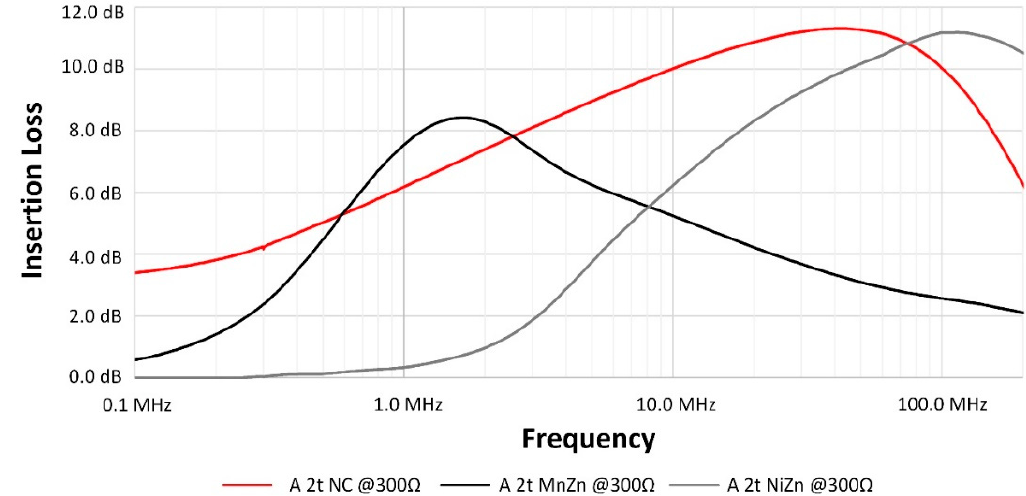
Figure 14. Comparison of the experimental insertion loss determined for NC, MnZn and NiZn sleeve ferrite cores by winding two turns.